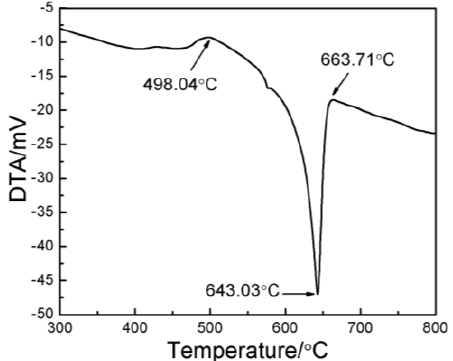
Figure 2. A DTA curve for 2024 Al p .